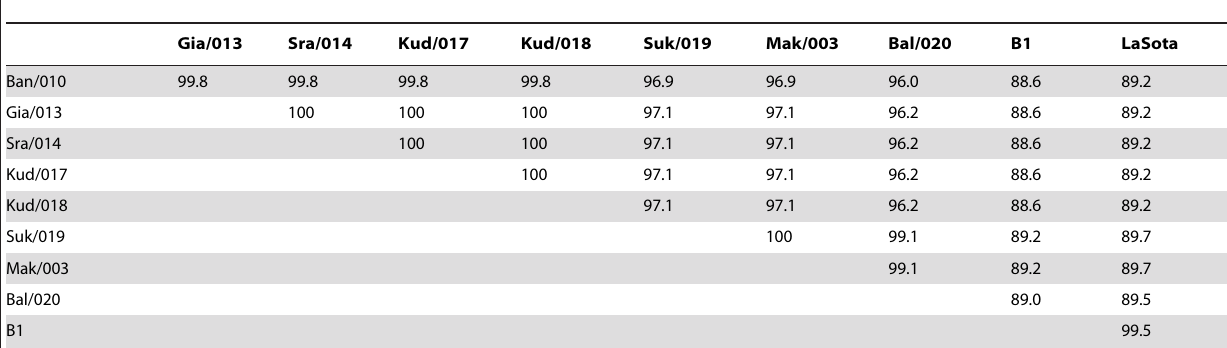
Table 2. Identities of amino acid sequences of F